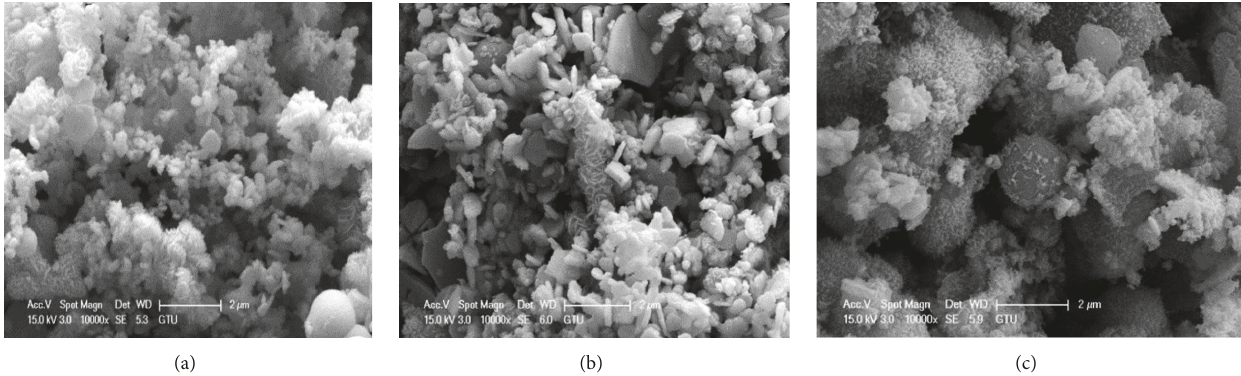
Figure 4: SEM micrographs of synthesized CIS powder at 240 ∘ C for (a) 10h, (b) 20 h, and (c) 40h with triethanolamine solvent.